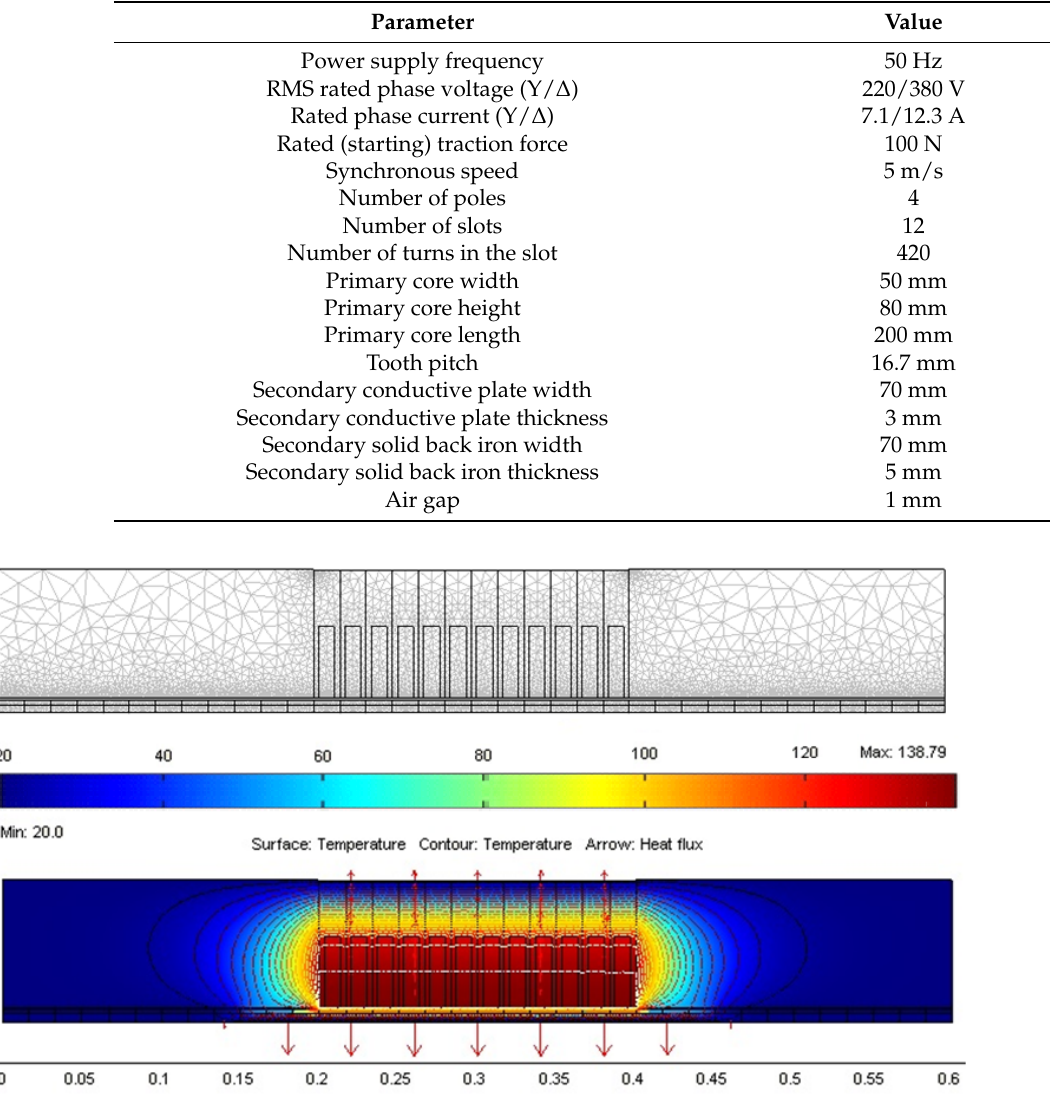
Figure 7. The results of thermal calculation according to the FEM model.